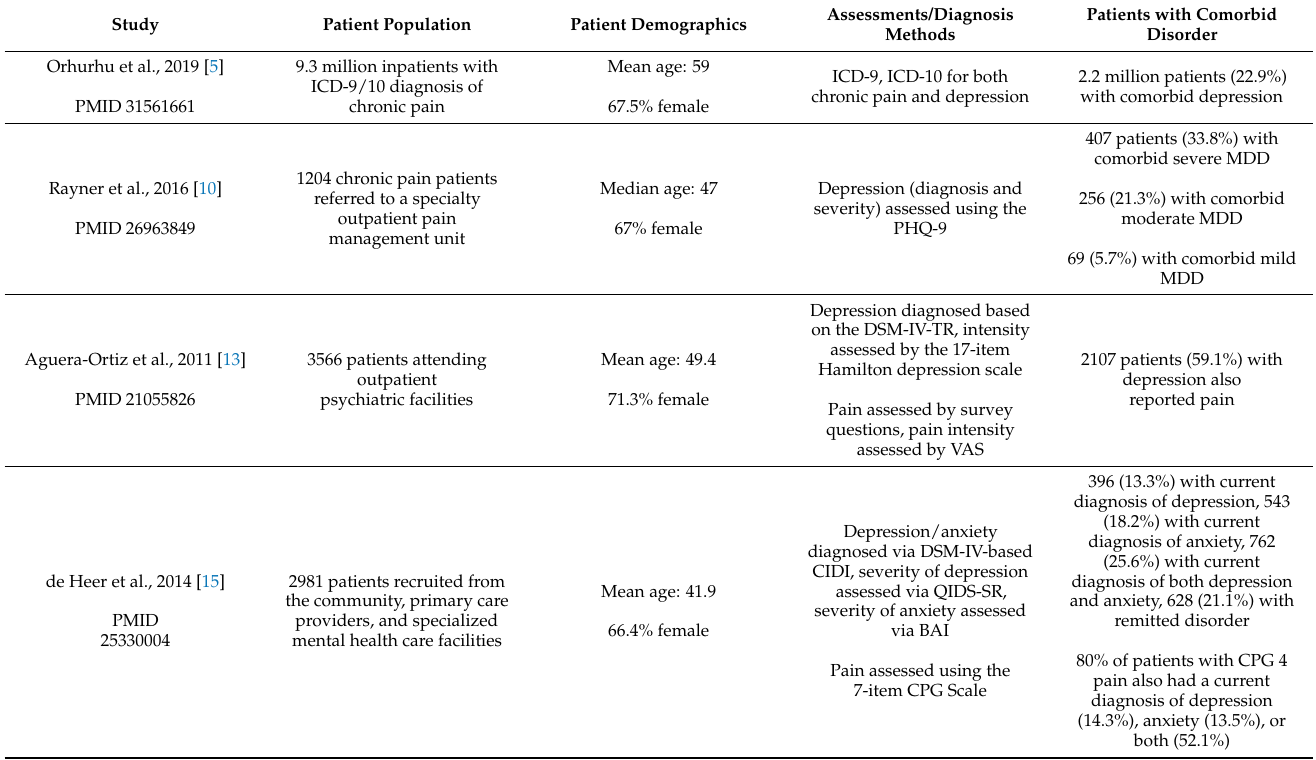
Table 1. Summary of studies analyzing the frequency of comorbid chronic pain and